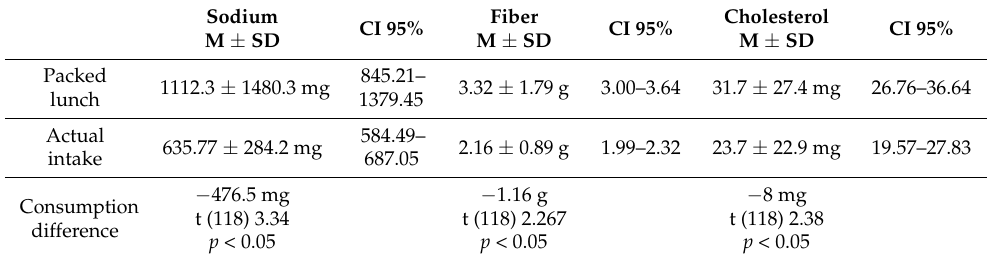
Table 3. Packed school lunch content versus actual intake of select health-related nutrients ( n = 118).